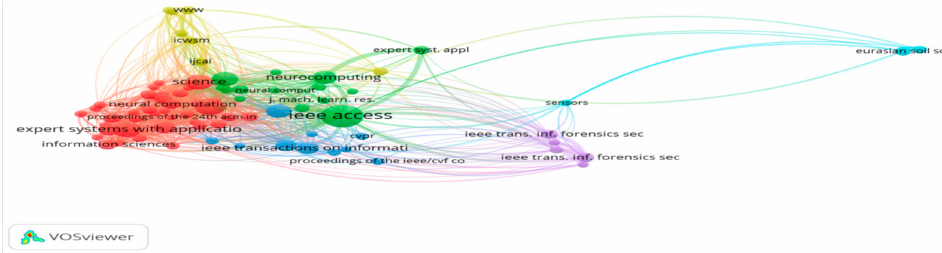
Figure 21. Co-citation